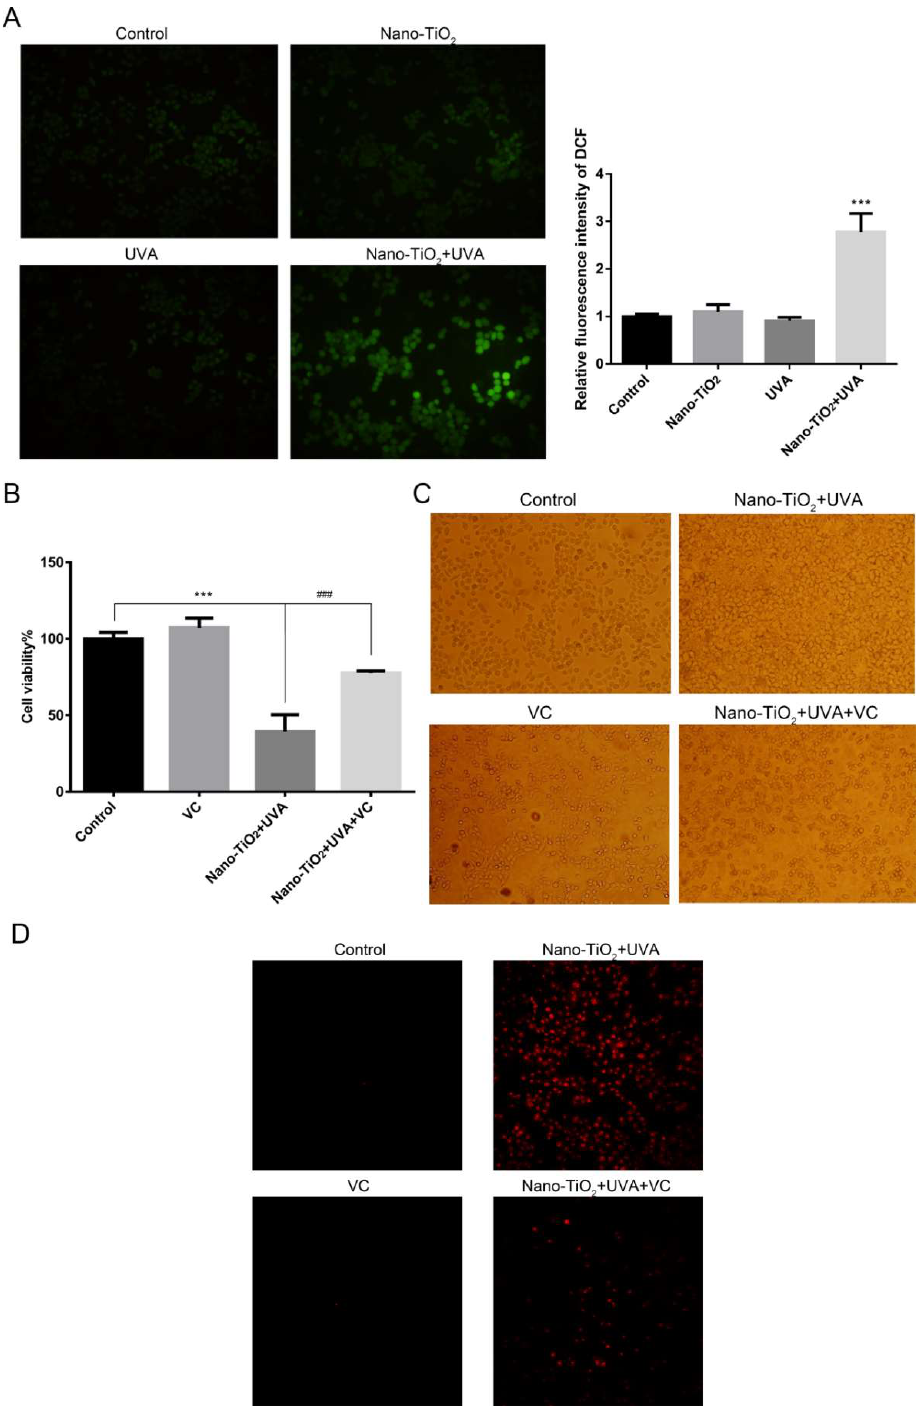
Figure 4. The effects of reactive oxygen species (ROS) generated by nano-TiO 2 and UVA on cell viability and cell necrosis. ( A )The generation of ROS was detected by 2′,7′-dichlorodihydrofluorescein diacetate (DCFH-DA) probe. The average fluorescence intensity of ROS was quantified by Image J, n = 3, *** p < 0.001, compared with control group. ( B ) MTT was used to detect the cell viability after added 0.4 mM VC, n = 5. *** p < 0.001, compared with control group; ### p < 0.001, compared with adding VC before and after. ( C ) The morphological changes of the cells were observed after added 0.4 mM VC. ( D ) PI fluorescence staining was used to detect the integrity of cell membrane after added 0.4 mM VC.